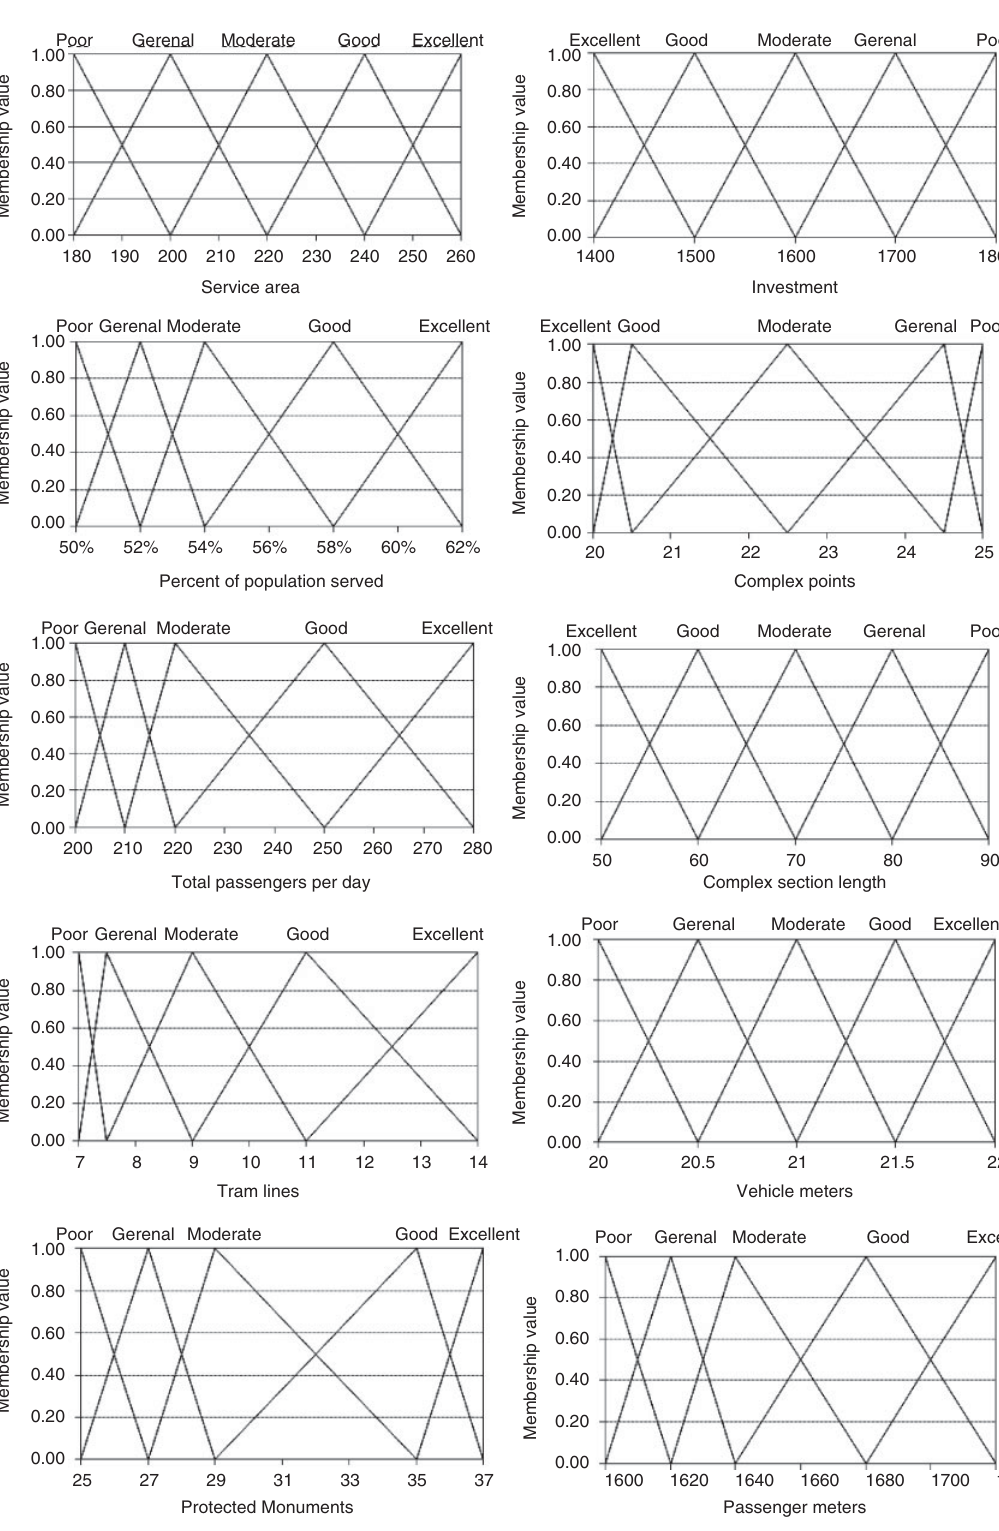
Fig. 5. Membership functions of the basic layer